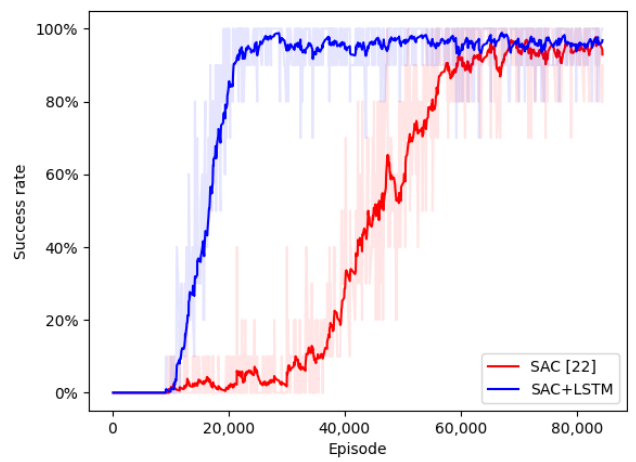
Figure 9. Comparison of success